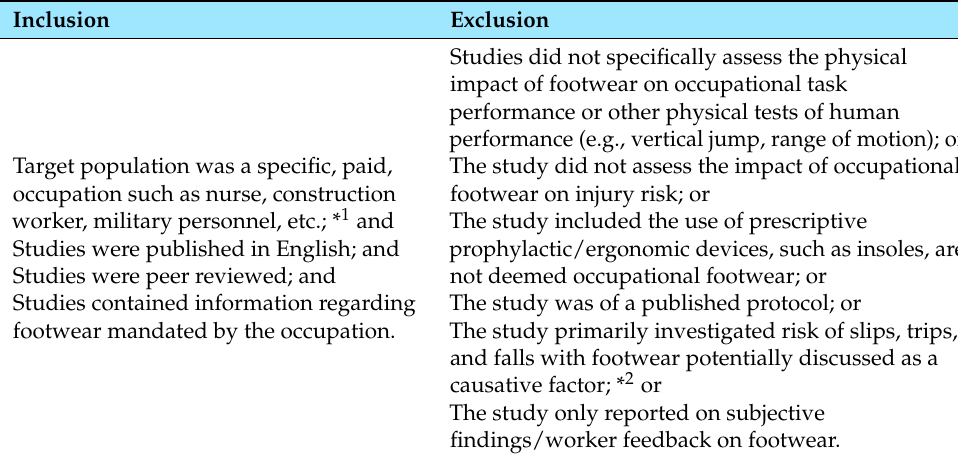
Table 2. Inclusion and exclusion